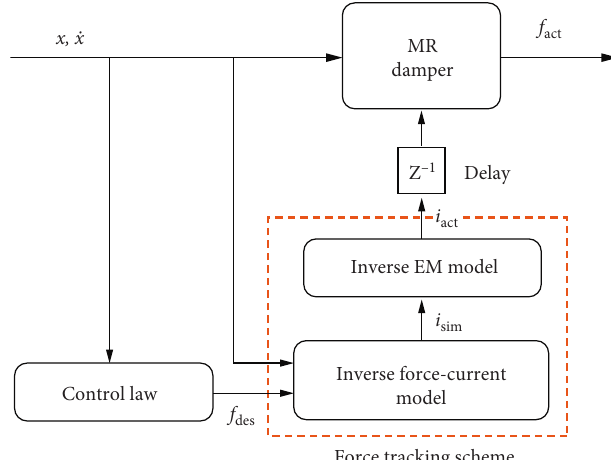
Figure 7: Experimental schematics of inverse model-based force tracking